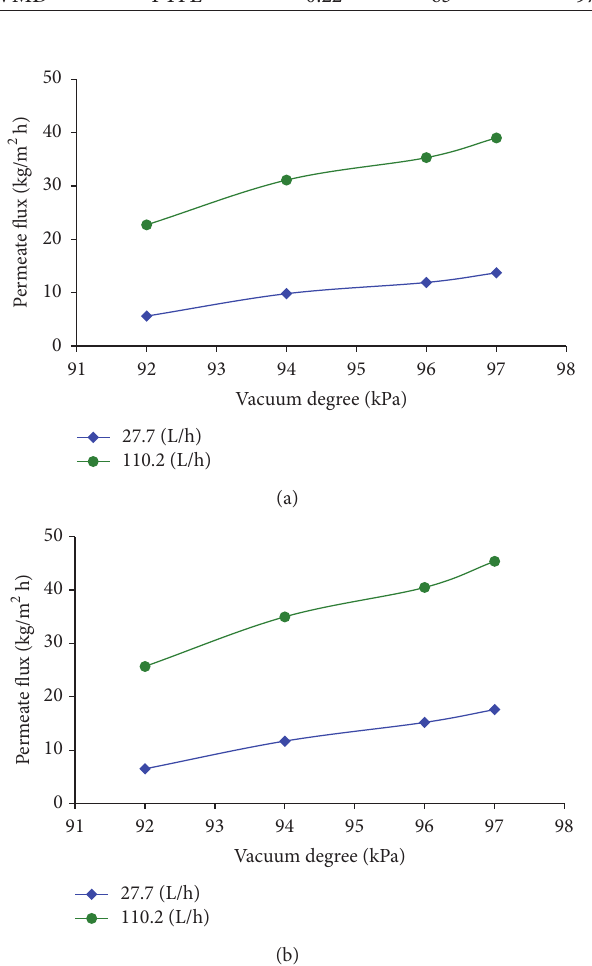
Figure 12: The effect of the vacuum degree on the permeate flux at 27.7 and 110.2(L/h) feed flow rates; a 55 ∘ C feed temperature and 35,000 mg/L of NaCl for the (a) PVDF and (b) PTFE membranes. concentration polarization effects reduce the evaporation